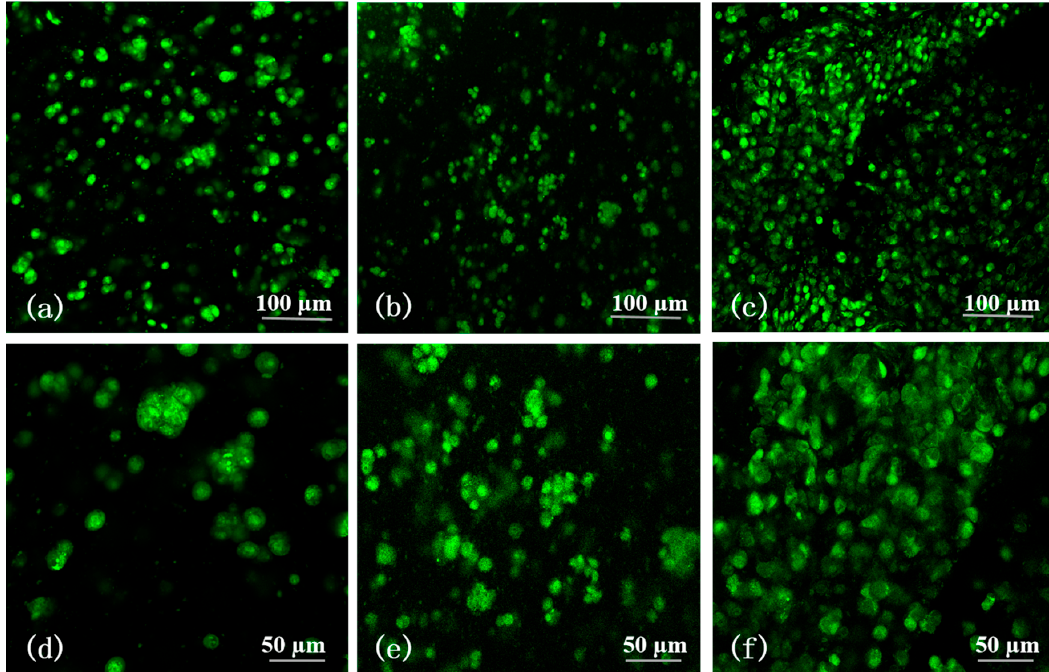
Figure 8. Viability of human neuroblastoma SH-SY5Y cells encapsulated in the alginate-gelatin-interpenetrating polymer network (A-G-IPN) with acridine orange (AO)/propidium iodide (PI), (i.e., AO/PI), staining: ( a ) a laser confocal microscope (LSM) image showing that all the SH-SY5Y cells are alive in a green color with AO/PI staining after 1 day of an in vitro culture. ( b ) A LSM image showing that all the SH-SY5Y cells are alive in a green color with AO/PI staining after 3 days of an in vitro culture. ( c ) A LSM image showing that all the SH-SY5Y cells are alive in a green color with AO/PI staining after 5 days of an in vitro culture. ( d ) A magnified image of ( a ). ( e ) A magnified image of ( b ). ( f ) A magnified image of ( c ).